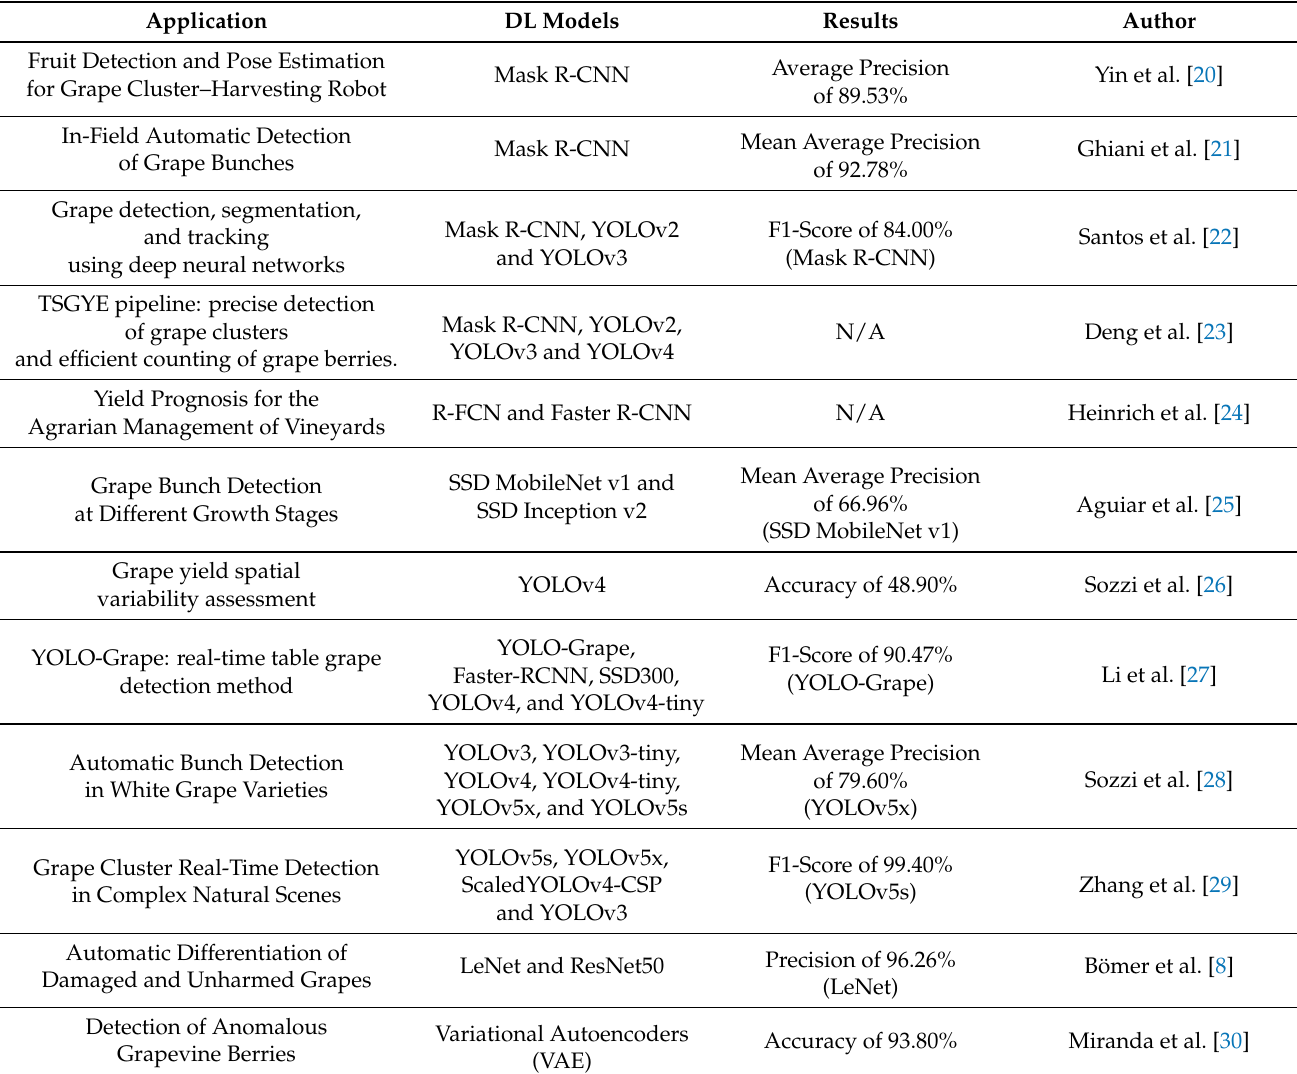
Table 1. State-of-the-art DL for optimal and damaged grapevine bunch